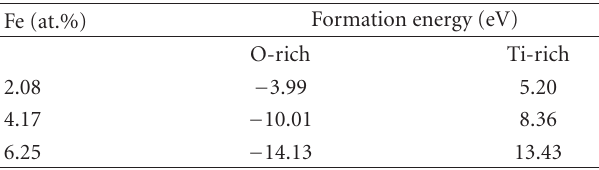
Table 2: Formation energy of Ti 1 − x Fe x O 2 for di ff erent Fe concen- trations.